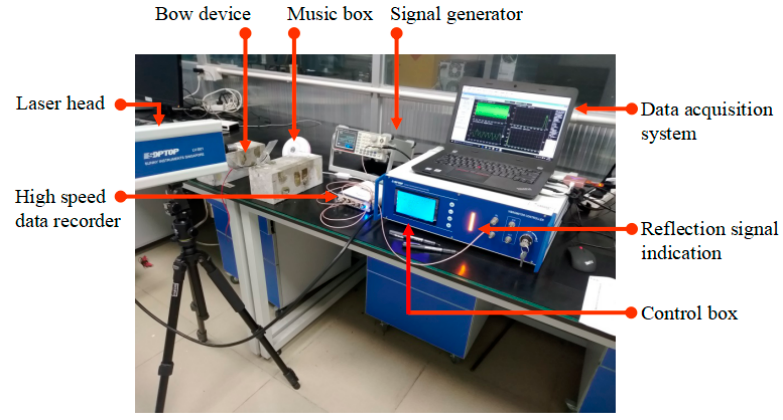
Figure 2. Frequency measurement of steel wire in bow shaped device using LDV.